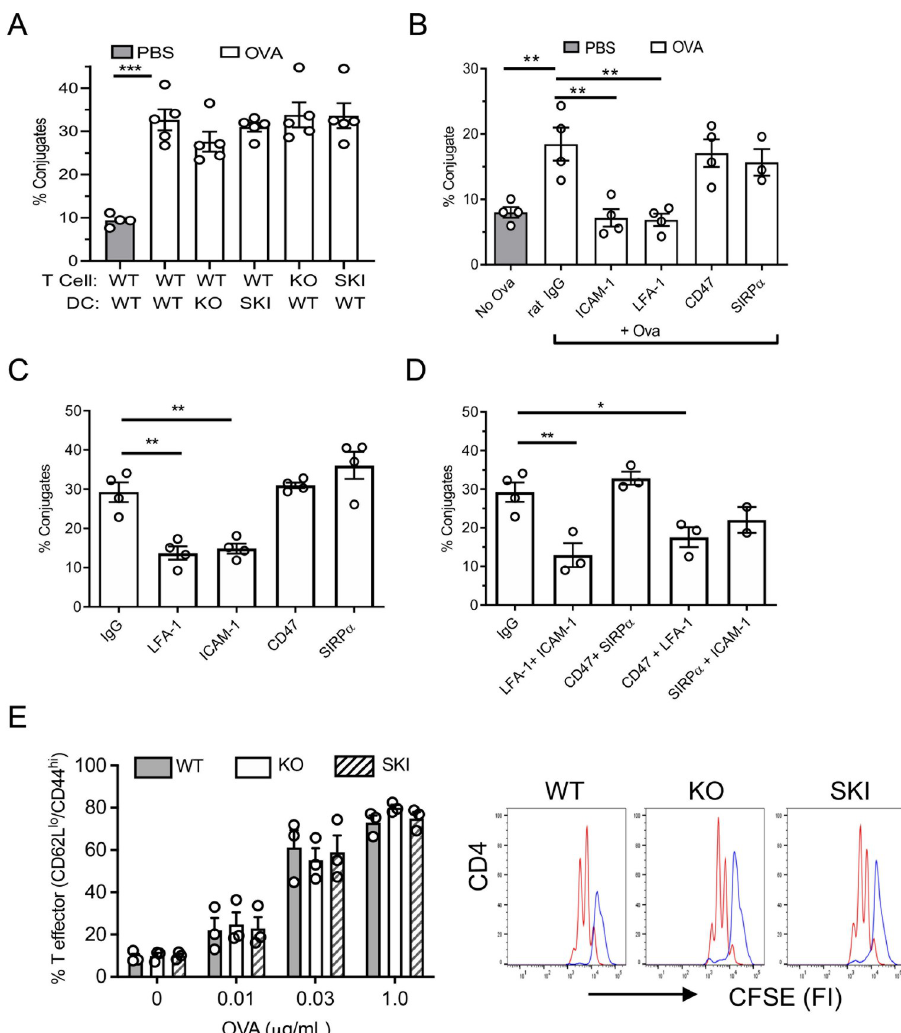
Fig 3. Interaction of CD47 and SIRP α does not play a role in OVA-induced CD4 + T cell production in vitro. (A) Conjugate formation between murine WT, Cd47 KO and SKI OTII CD4 + T cells with BMDC from WT, SKI and Cd47 KO mice at baseline and with OVA or PBS control. Means ± SEM from 3 independent studies, each performed with duplicate samples. ��� p < 0.001, by one-way ANOVA with Tukey test. (B) Conjugate formation of WT BMDC and OTII CD4 + T cells in presence of various function blocking mAb specific for molecules indicated on x-axis. Means ± SEM from 3 independent studies, each performed with duplicate samples. �� p < 0.01 by one-way ANOVA with Tukey test. ( C,D ) Conjugate formation between human CD4 + T cells and MDDC in presence of IgG control or blocking mAb specific for molecules indicated. Means ± SEM from n = 3 independent studies each performed with duplicate samples. � p < 0.05, �� p < 0.01, ��� p < 0.001 by one-way ANOVA with Tukey test. ( E ) Analysis of WT, Cd47 KO and SKI CD4 + T cell activation (CD44 hi CD62L lo ) and proliferation assessed by dye dilution after 48 h of coculture in vitro with indicated MDDCs, with or without OVA. Proliferation of Cd47 KO and SKI was not significantly different from WT. PBS treated, purple line; Ova stimulated, red line. The results are representative of 3 independent experiments. baseline by mAb to ICAM-1 or LFA-1, which is in line with the literature [37]. In contrast, function blocking anti-CD47 or SIRP α mAbs had no significant effect. We also verified these results in human cells in the conjugate assay, which was based on the HLA mismatch between blood monocyte derived DCs from one donor incubated with CD4 + T cells from different donors (Fig 3C and 3D). Function blocking mAb to CD47 or SIRP α alone or in combinations,